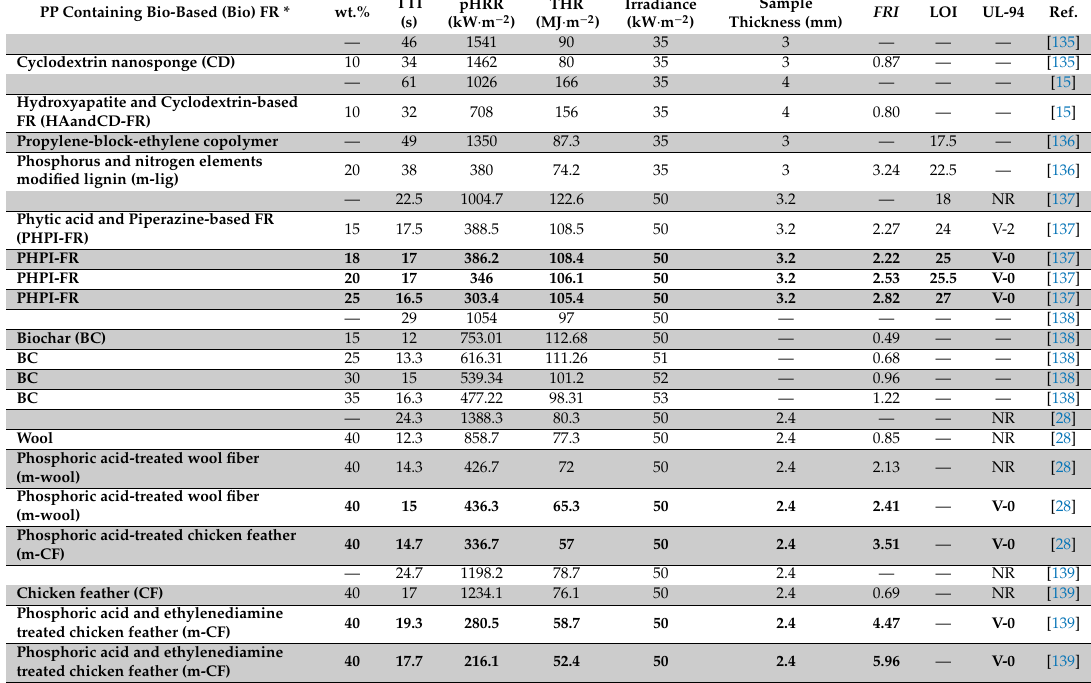
Table 5. Flame-retardant PP materials containing bio-based (Bio) flame retardants. Data are extracted from the literature: cone calorimetry parameters (TTI, pHRR, THR), LOI, and UL-94 values. The FRI values were calculated by authors of the present review. The name and the percentage of flame retardants are provided in separate columns. “wt.%” was used for loading level of additives, while “—” stands for the systems free of additive or the neat PP. * FR means flame retardant. Since all comparisons were made in terms of FRI , classification of polymers in terms of their flame-retardant properties was not surveyed based on the chemistry of additives, heat flux, sample thickness,